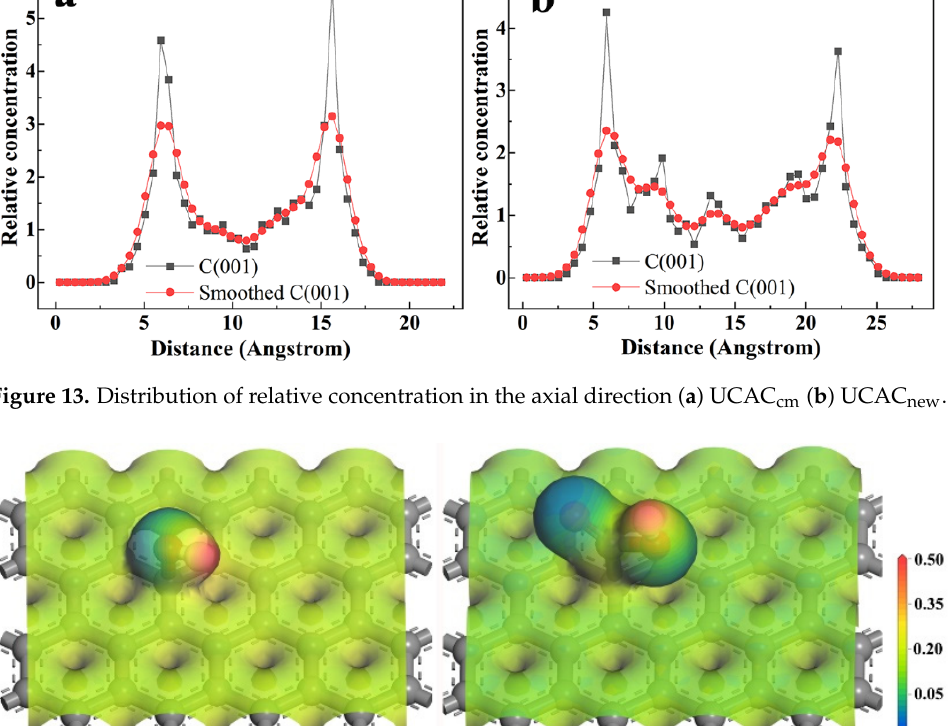
Figure 12. Adsorption site map and conformation diagram of the actual adsorption ( a , c ) UCAC cm ( b , d ) UCAC new. Figure 13. Distribution of relative concentration in the axial direction ( a ) UCAC cm ( b ) UCAC new.